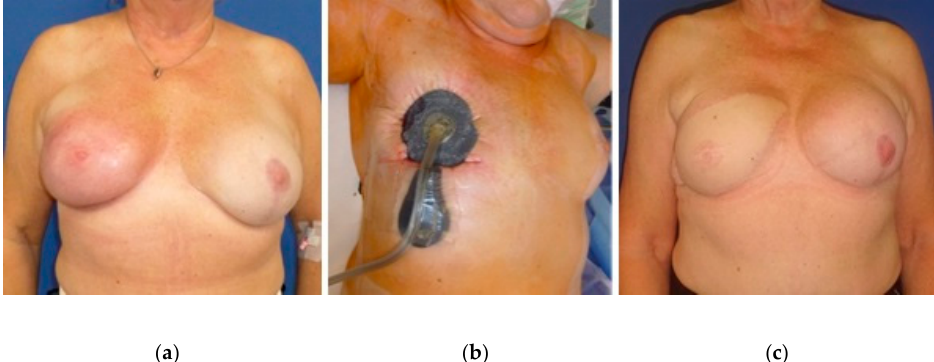
Figure 2. Example of NPWTi-d ( b ) in a 58-year-old patient with a history of breast cancer shown with PPBI. ( a ) Skin graft transplantation due to severe infection of the skin with necessary excision of the skin. ( c ) Five months later, the skin graft was removed, and the right breast underwent free ms1-TRAM flap reconstruction. The free ms1-TRAM flap was well perfused, and follow-up remained uneventful 6 weeks and 6 months later.